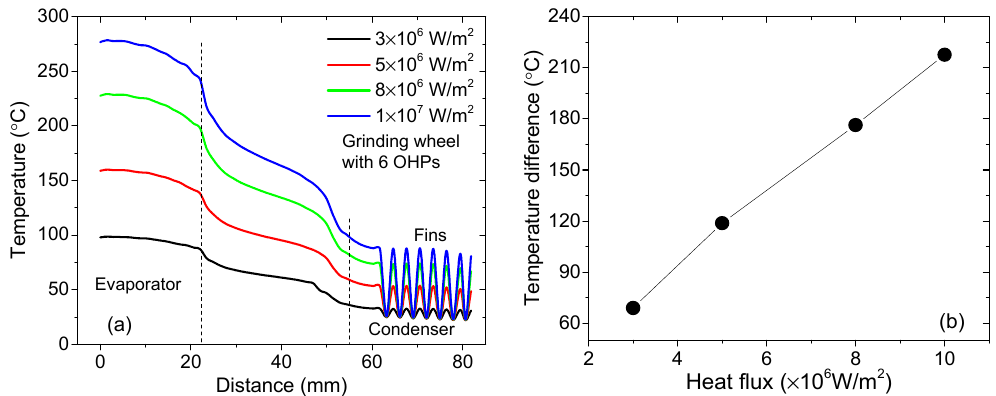
Figure 6. The highest temperature in the grinding zone under different grinding heat flux values.